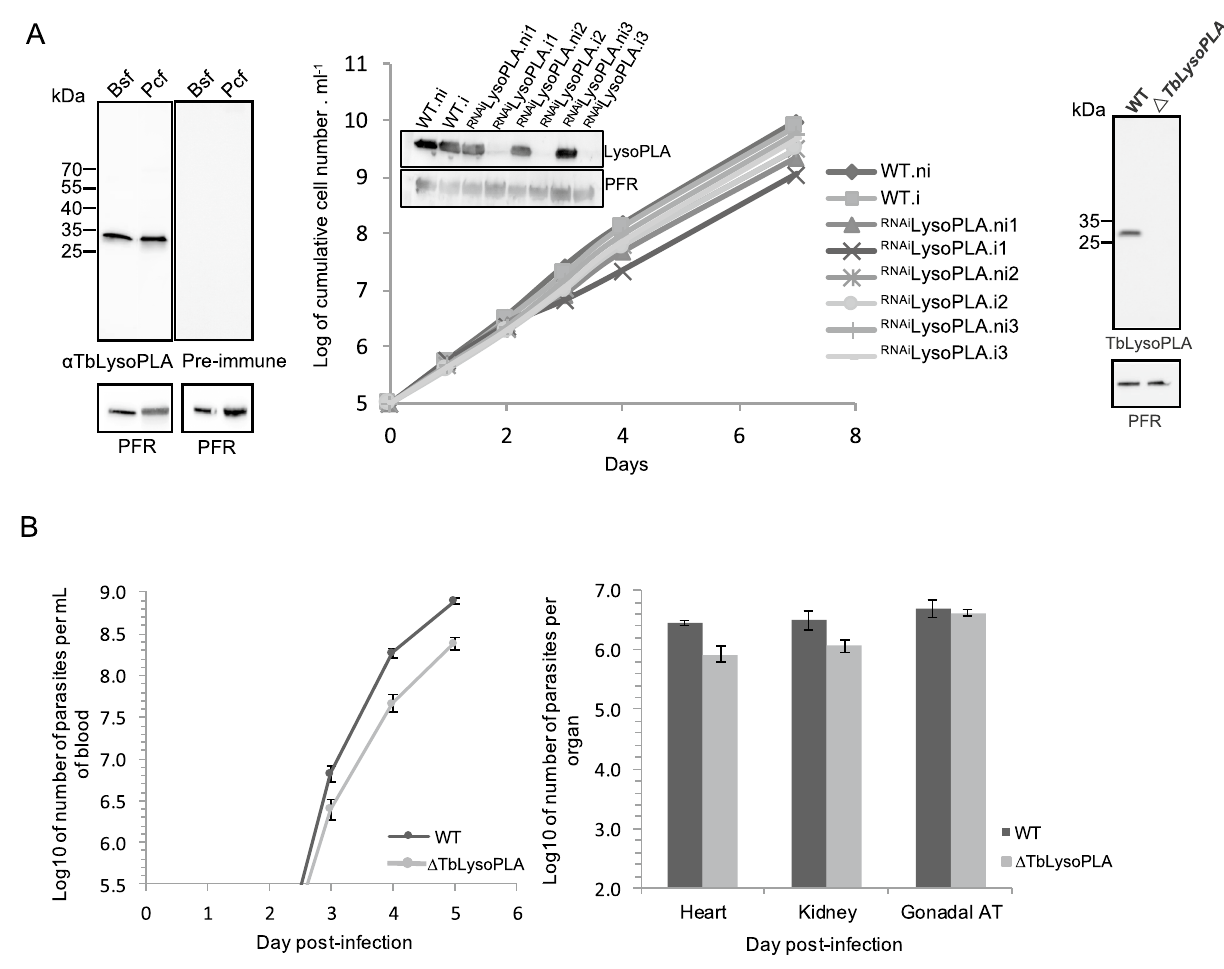
Figure 3. Analysis of bloodstream form mutants. ( A ) Left: TbLysoPLA is expressed in both bloodstream and procyclic forms. Total protein extracts from both forms of Tb were resolved by SDS-PAGE and transferred on nitrocellulose as described in materiel and method section. Membranes were probed with sera raised against TbLysoPLA and PFR. Right panel is a control with the pre-immune sera from the animal before immunisation with TbLysoPLA. Middle: inhibition of TbLysoPLA expression by interference RNA. Growth of the parental cell-line and 3 independant clones cultivated with (i) or without (ni) tetracycline. Right panel shows the ∆TbLysoPLA validation by Western Blotting as TbLysoPLA is not detected anymore. A specific affinity-purified anti-TbLysoPLA antibody was used and PFR was used as loading control. ( B ) Mice infection with wild-type (dark grey) and ∆TbLysoPLA (light grey) Tb427 BSF. Error bars represent the standard error of the mean (n = 4 per group). Left: parasitemia of infected mice quantified by hemocytometer. Right: number of parasites in heart, kidney and gonadal adipose tissue, 5 days after infection, quantified by